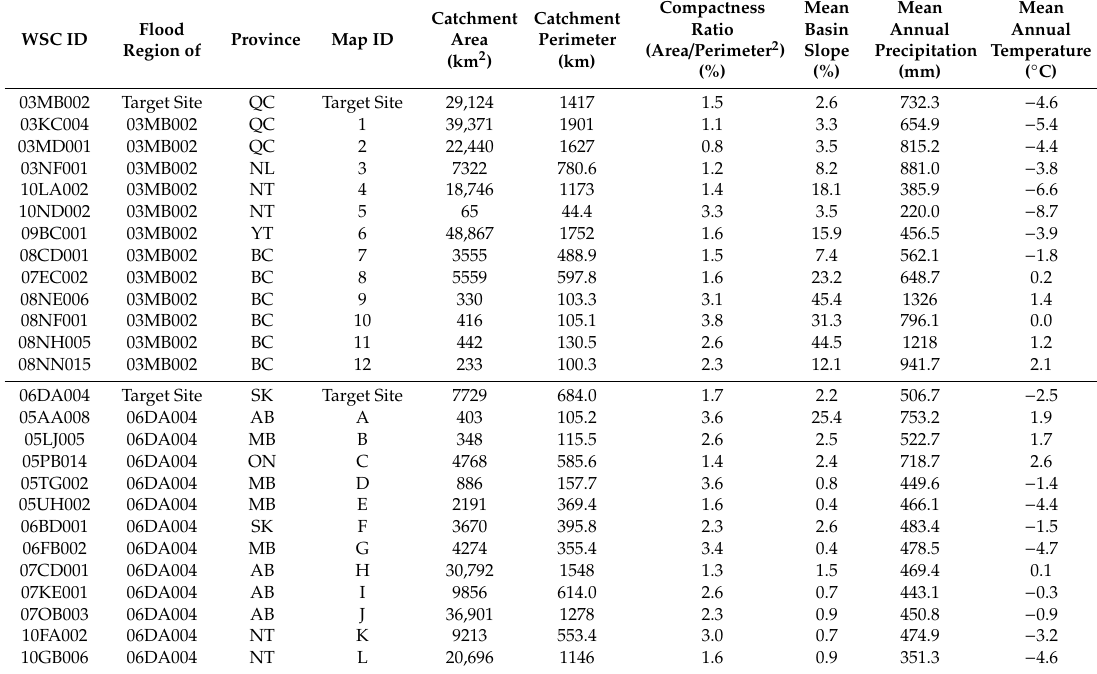
Table 3. Physiographic variables for WSC 03MB002 and WSC 06DA004 and their regions formed based on flood